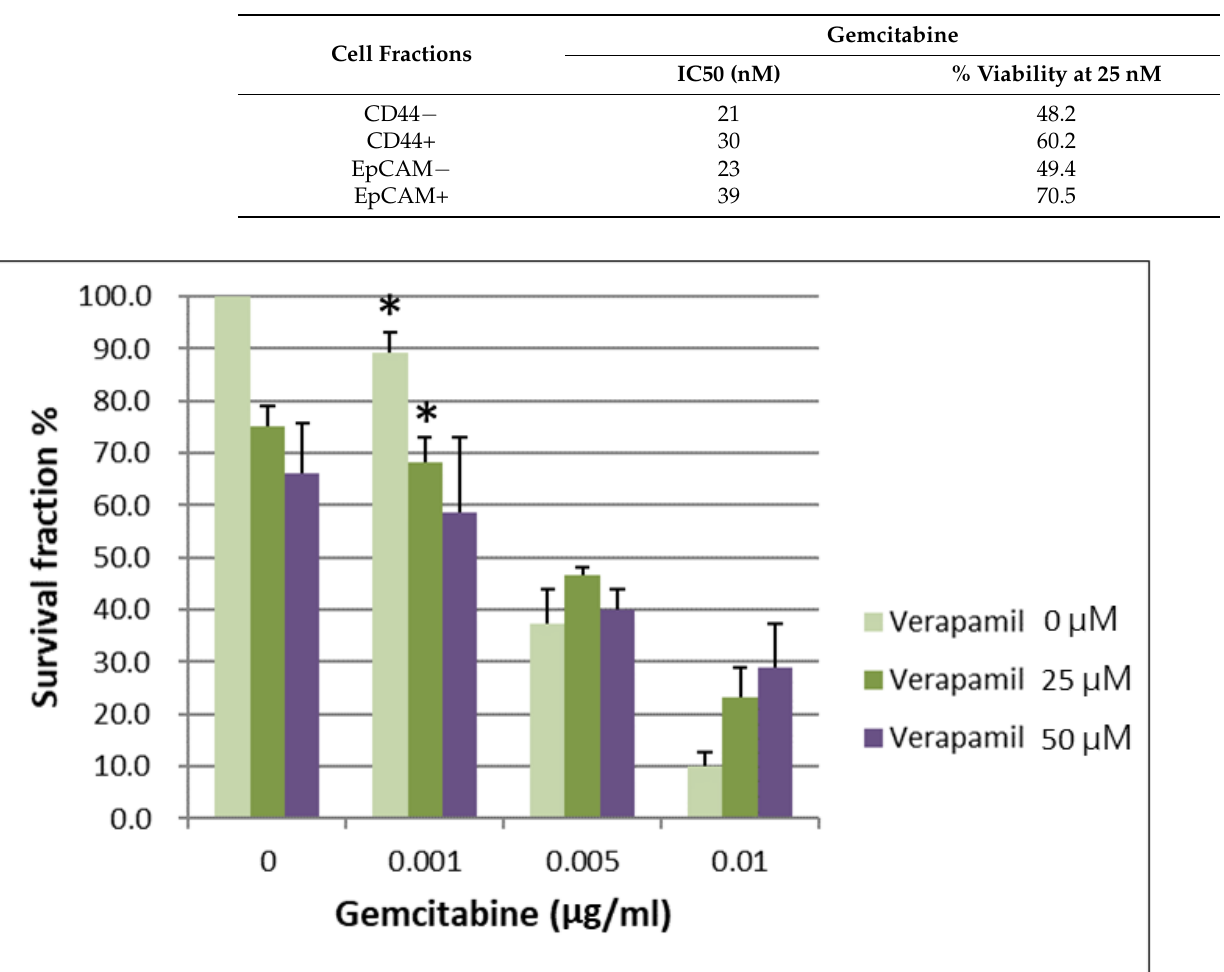
Figure 4. The survival of CD44+ cancer stem cells of BxPC-3 PDAC cells treated with different con- centrations of verapamil and gemcitabine is shown. Verapamil 25 and 50 µM exerted the best chemotherapeutic effects when gemcitabine concentration of 0.001 µg/mL was used, * < 0.05. (Mean ± SD). 2.3. Responsibility of ABC Transporters for the Acquisition of Multidrug Resistance ABC transporters with expression altered by >1.5 fold in CD44+ cells compared with CD44− cells (RQ: Relative Quantity RNA) (Table 2). The expression levels of chemo- resistance genes ABCC1, ABCG2, NOTCH2 and JAG-1 in BxPC-3 cells were compared between CSCs and non-CSCs, and only ABCG2 exhibited a higher expression in CD44+ CSCs than in CD44− non-CSCs. For EpCAM+ CSCs and EpCAM− non-CSCs, the differ- ence was similar to that between CD44+ CSCs and CD44− non-CSCs (Figures 5 and 6, p < 0.05).